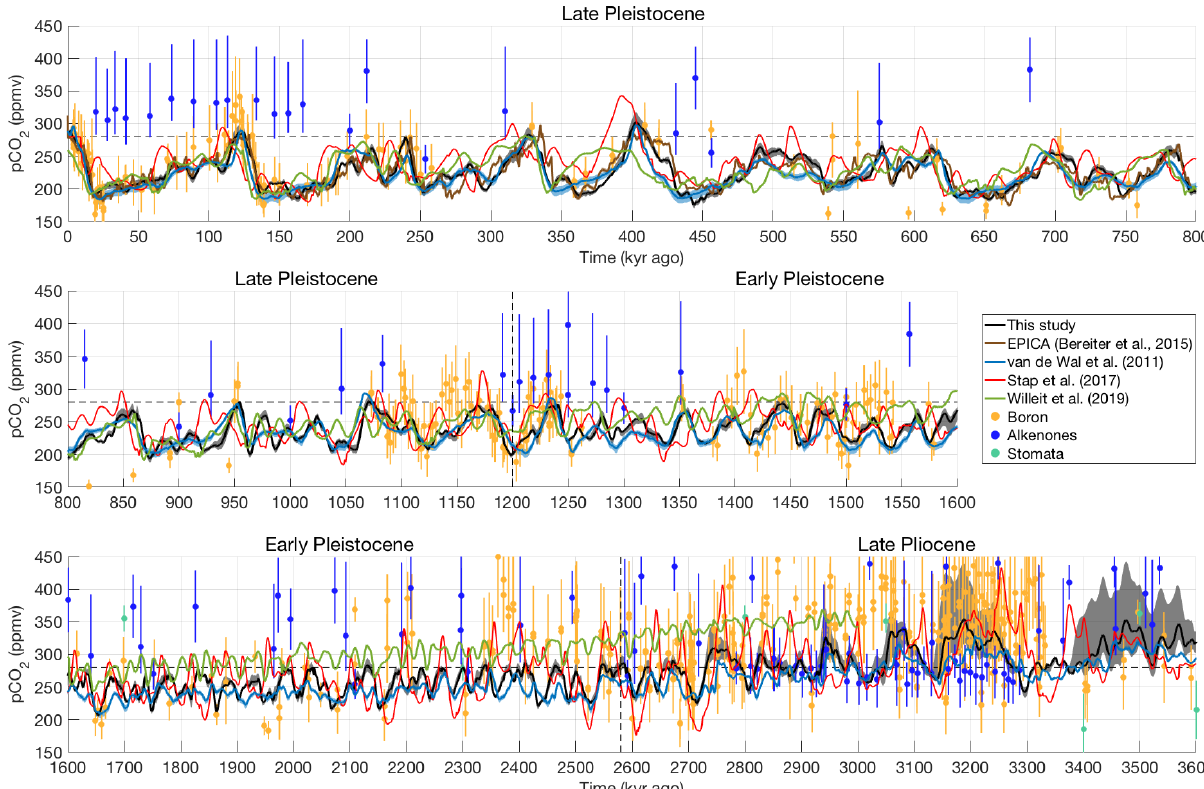
Figure 6. Reconstructed atmospheric CO 2 for the entire simulation period, compared to the EPICA Dome C ice-core record (Bereiter et al., 2015); compared to three different reconstructions based on ice-sheet–climate models (van de Wal et al., 2011; Stap et al., 2017; Willeit et al., 2019); and compared to chemical proxies based on 11 B ratios (Hönisch et al., 2009; Seki et al., 2010; Bartoli et al., 2011; Martínez-Botí et al., 2015; Stap et al., 2016; Chalk et al., 2017; Dyez et al., 2018; Sosdian et al., 2018), alkenones (Seki et al., 2010; Badger et al., 2013; Zhang et al., 2013), and stomata (Kürschner et al., 1996; Stults et al., 2011; Bai et al., 2015; Hu et al., 2015). The pre-industrial value of 280ppmv is shown by a dashed